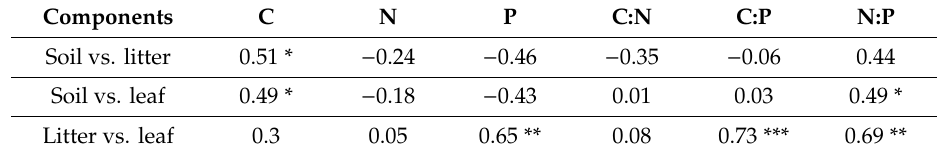
Table3. CoefficientsofcorrelationsforC,N,andPcontentsandtheirratiosbetweenecosystemcomponents.